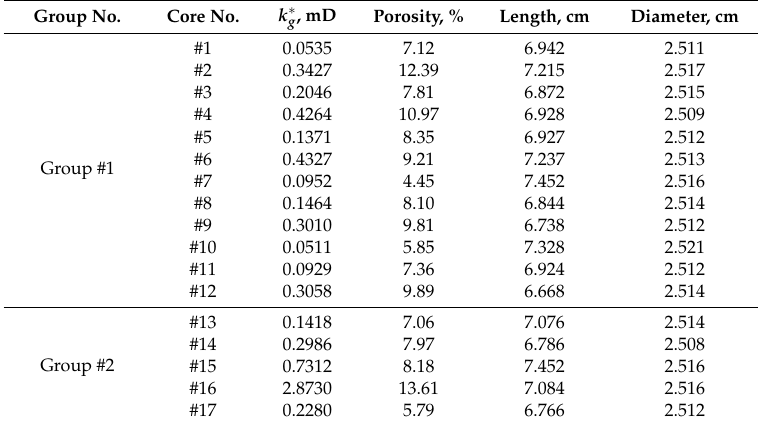
Table 1. Properties of 17 core samples collected from the tight gas reservoir Group No. Core No. k ∗ g , mD Porosity, % Length, cm Diameter, cm